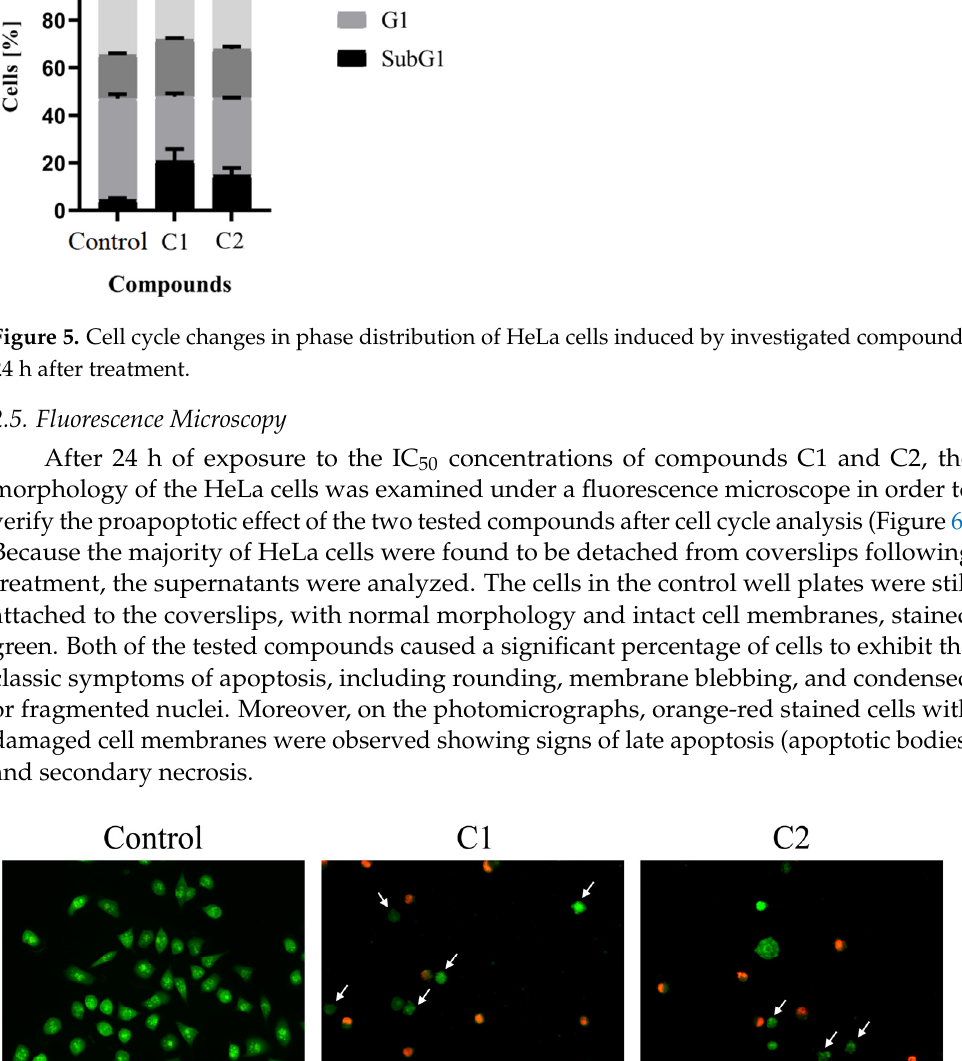
Figure 7. Scratch assay result chart showing percentages of gap reduction after 24 h treatments with IC 20 concentrations of compounds C1 and C2 (**** p < 0.0001).